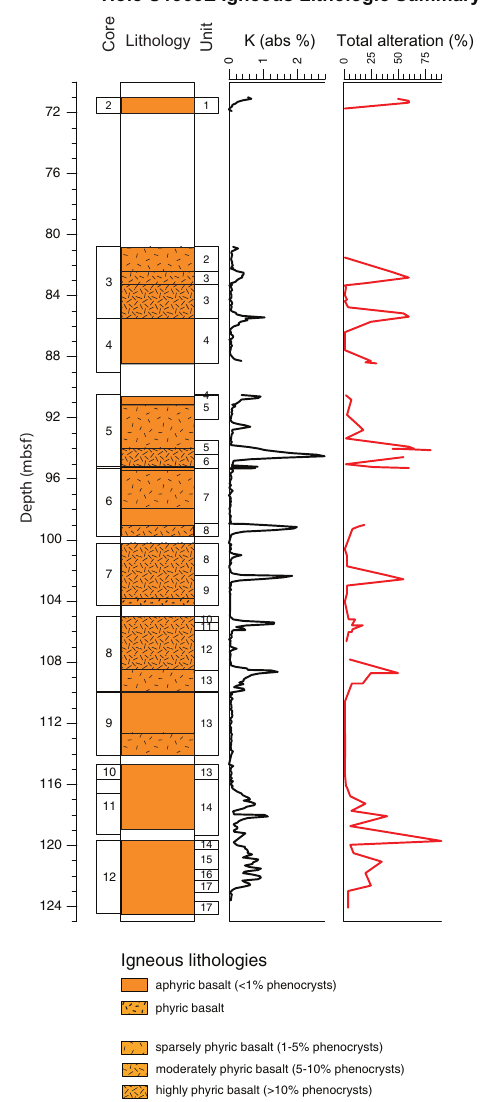
Figure 5. Relationship between igneous units, visually observed alteration intensity, and potassium content (determined by NGR core logging), Hole